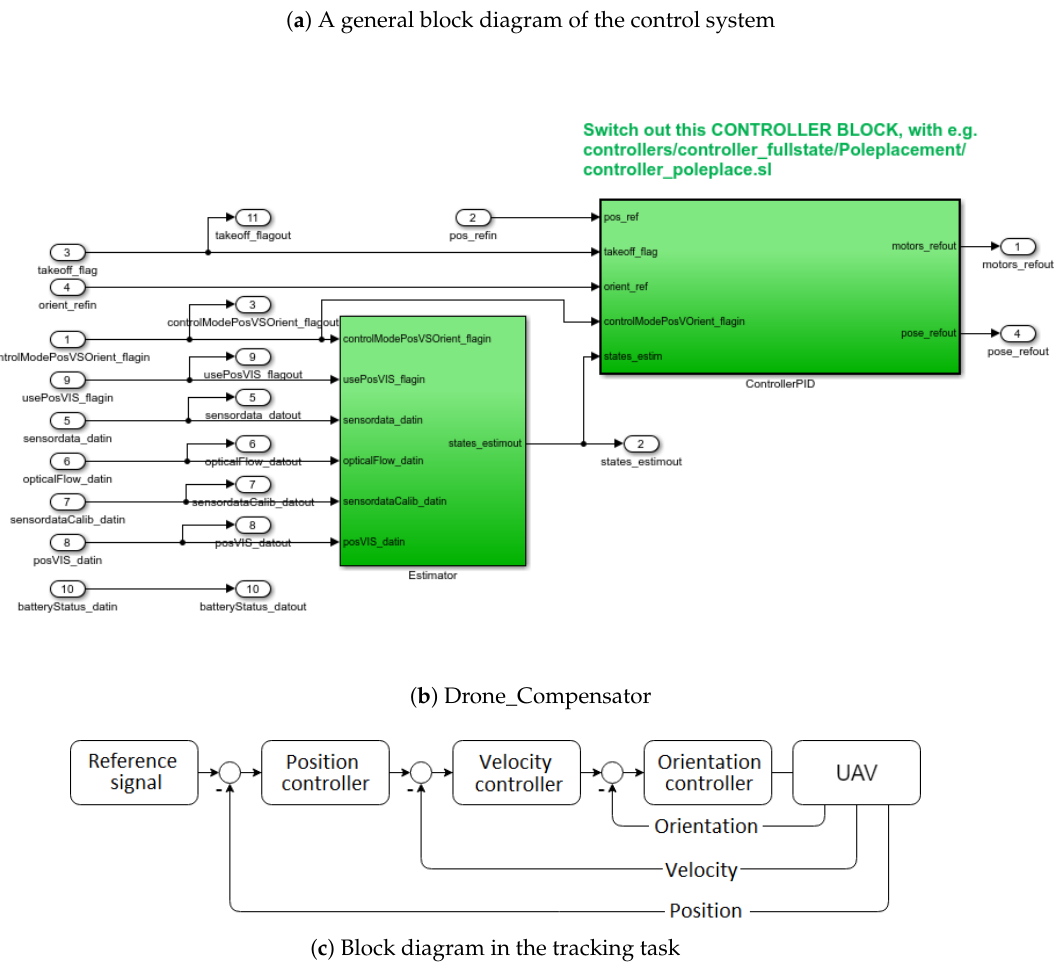
Figure 10. Matlab model of the Rolling